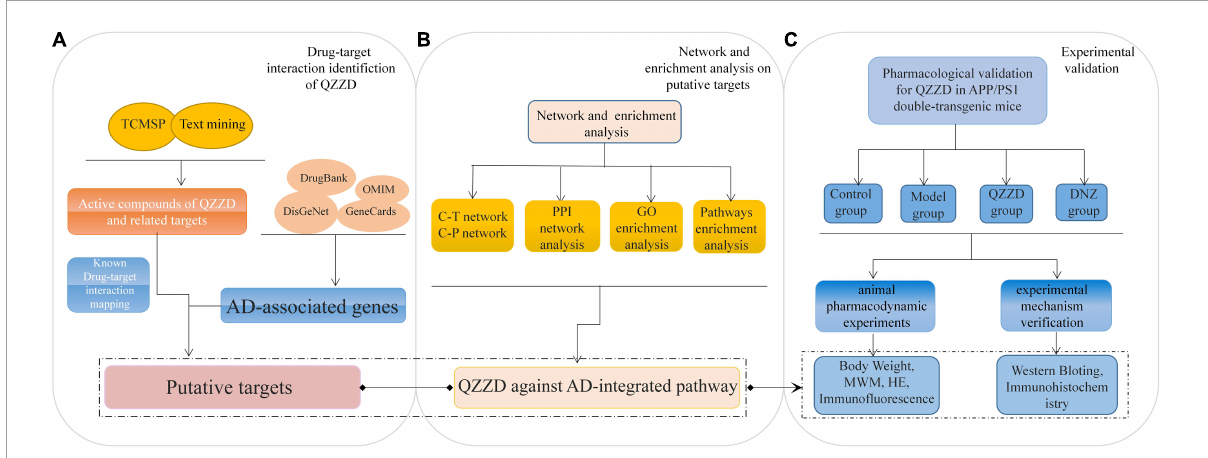
FIGURE1 Flowchart of network pharmacology approach to mechanism of QZZD against Alzheimer’s disease. (A) Drug-target interaction identification of QZZD. (B) Network and enrichment analysis (on putative targets). (C) Experimental validation ( in vivo to understand the pharmacological mechanism of QZZD against Alzheimer’s